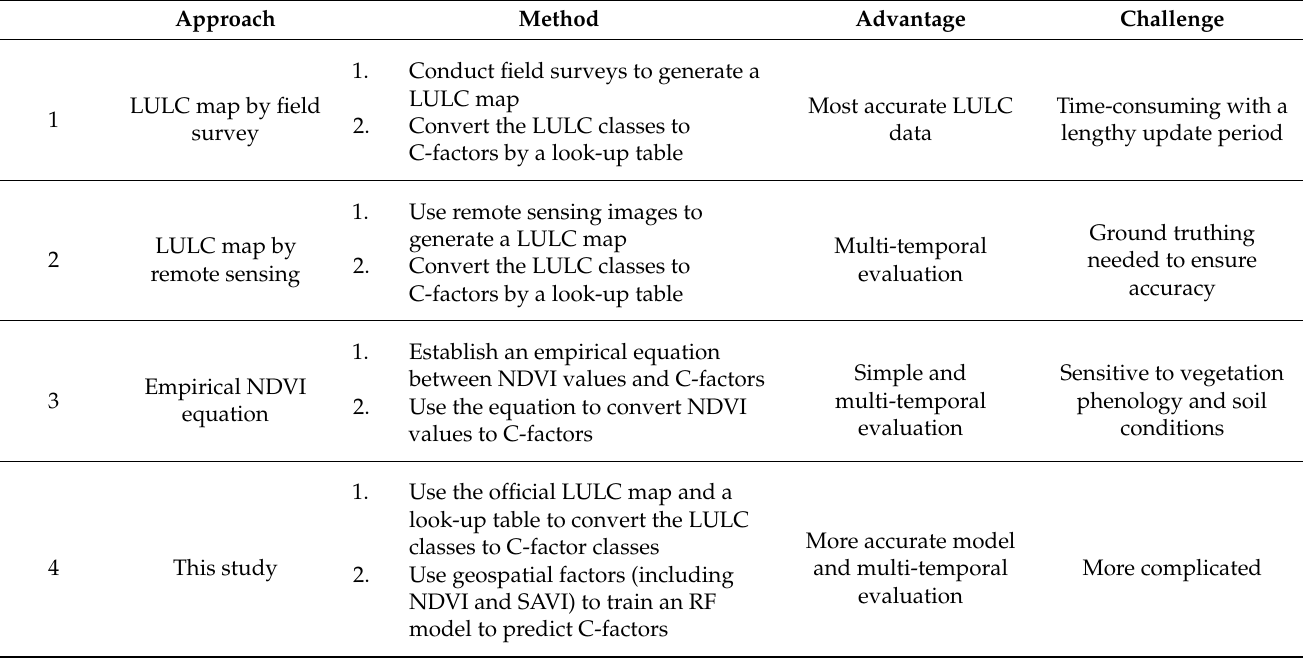
Table 1. Comparison of typical approaches for estimating the